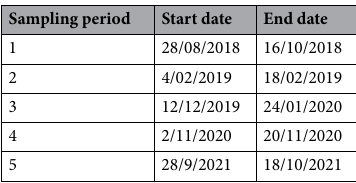
Table 2. The dates that each sampling period was undertaken for the above-ground vegetation